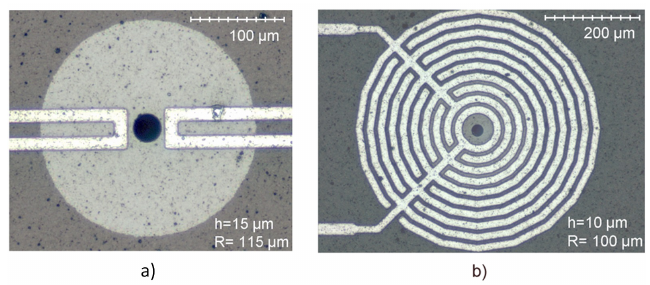
Figure 13. Optical microscope images of Al/SiC ring resonators with: ( a ) a pair of u-shaped electrodes; ( b ) an interdigitated electrode [46]. Reprinted with permission from J. Vac. Sci. Technol. B, 27, Mastropaolo et al., Electrothermal actuation of silicon carbide ring resonators, 3109–3114, c (cid:13) 2009, American Vacuum Society.